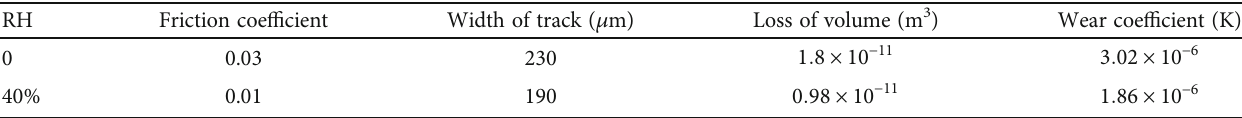
Table 4: Wear behaviour of DLC in various